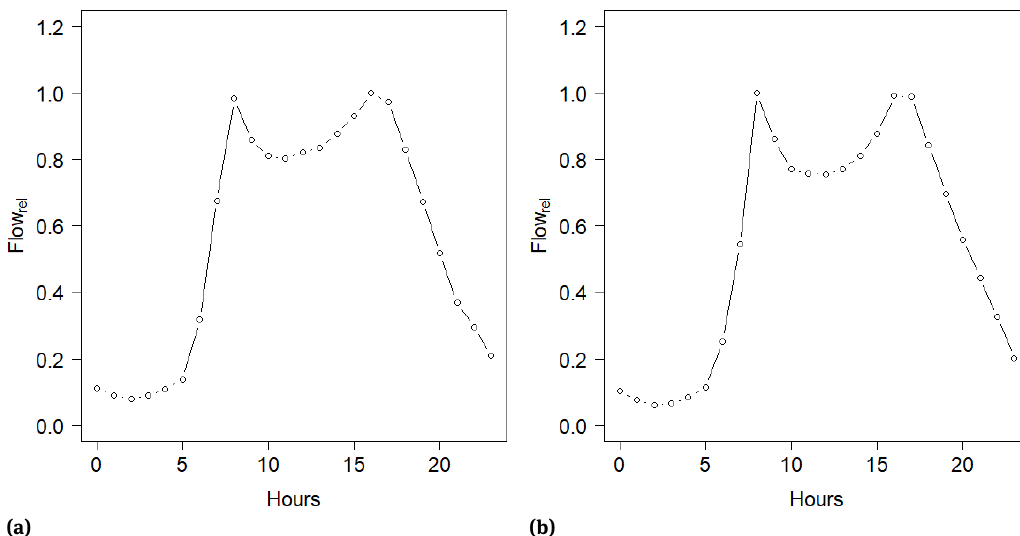
Figure 9: Relation between the normalized annual hourly traflc flow for all set of vehicles and time at business days a) in 2012, b) in 2016